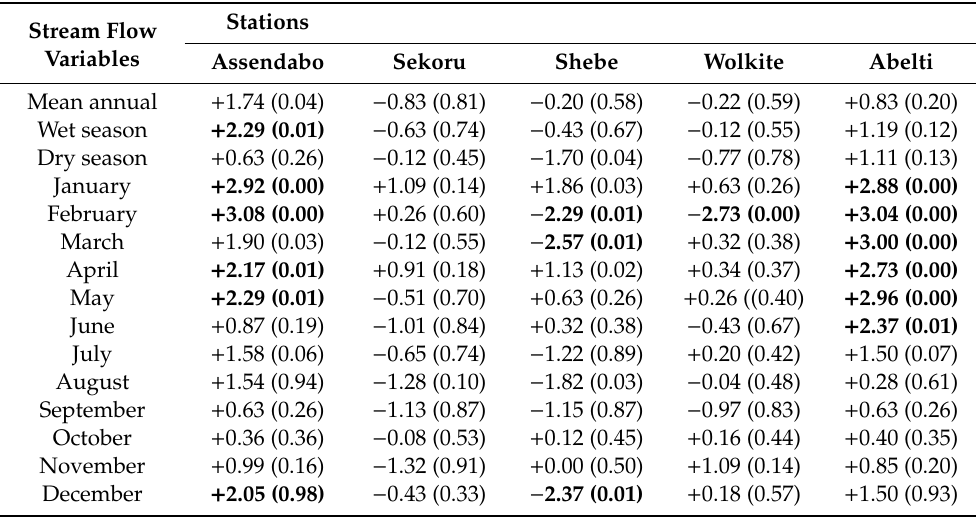
Table 5. Trend results of Mann–Kendall ‘Z’ statistic, and ‘p’ value (in brackets) for streamflow time series. Bold numbers indicate statistically significant trends at the 0.05 level. Positive/negative sign of Z indicates increasing/decreasing trend, respectively.